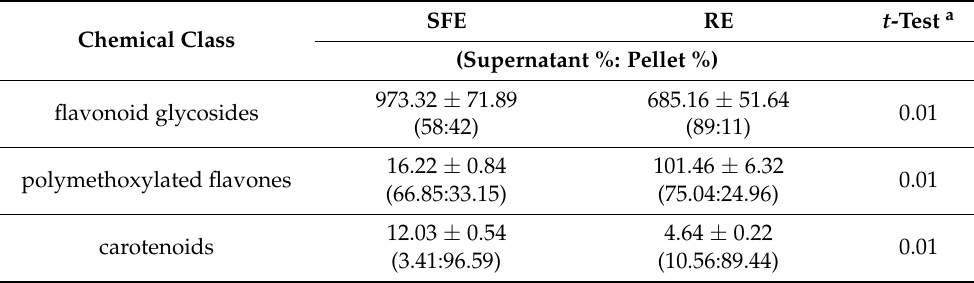
Table 2. Effect of shear force extractor (SFE) and reamer extractor (RE) types on total flavonoid glycosides, polymethoxylated flavones, and carotenoid content in “Valencia” orange juice (mg L − 1 juice) and the distribution between supernatant and pellet (supernatants %:pellets %). SFE RE t -Test a Chemical Class (Supernatant %: Pellet %) 973.32 ± 71.89 flavonoid glycosides (58:42) polymethoxylated